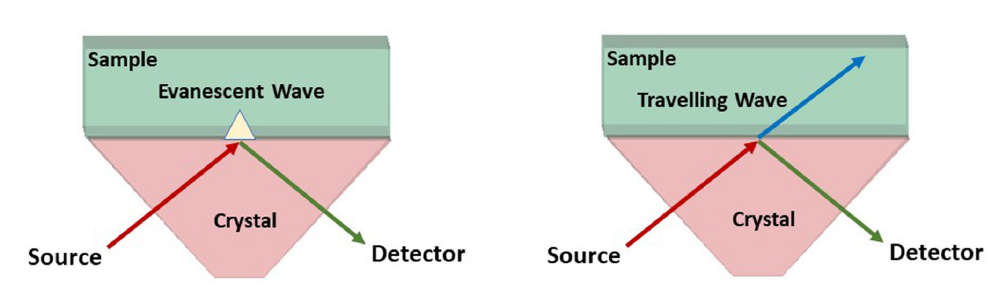
Figure 1. The schematic representation of the ATR apparatus. ( Left ) “True ATR” mode, where the incident radiation is totally reflected at the sample/crystal interface. ( Right ) Partial reflection/partial transmission mode, where some of the signal is transmitted into the sample as a travelling